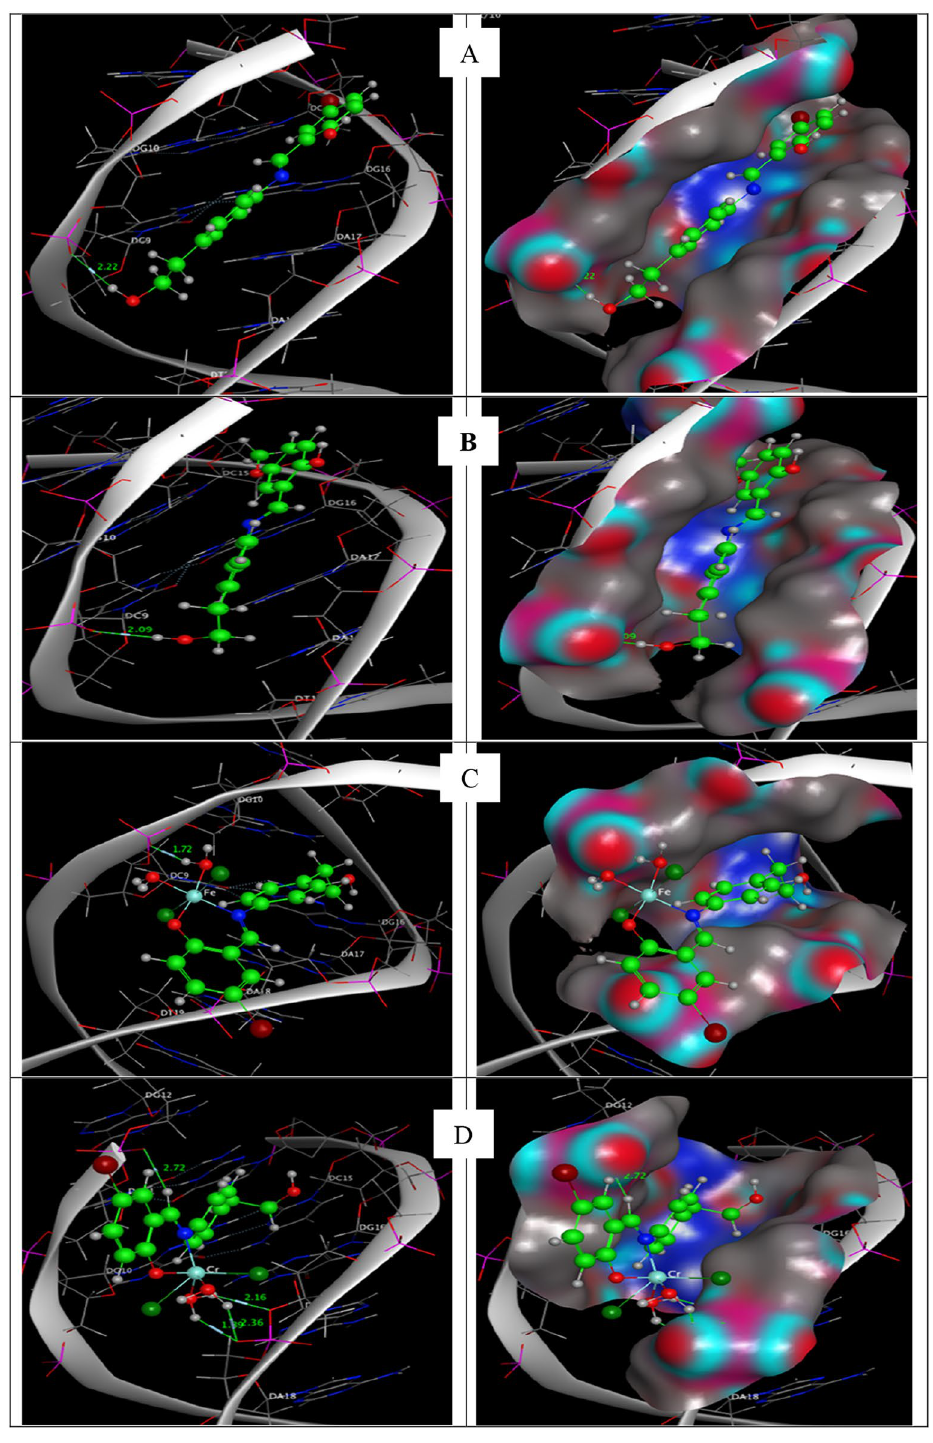
Figure 15. Molecular docking studies showed the interaction of HL1 and HL2 with the active site of the human DNA receptor, as well as with [Fe(L1)(H 2 O) 2 Cl 2 ](C), [Cr(L1)(H 2 O) 2 Cl 2 ](D), [Cr(L2)(H 2 O) 2 Cl 2 ] (E)